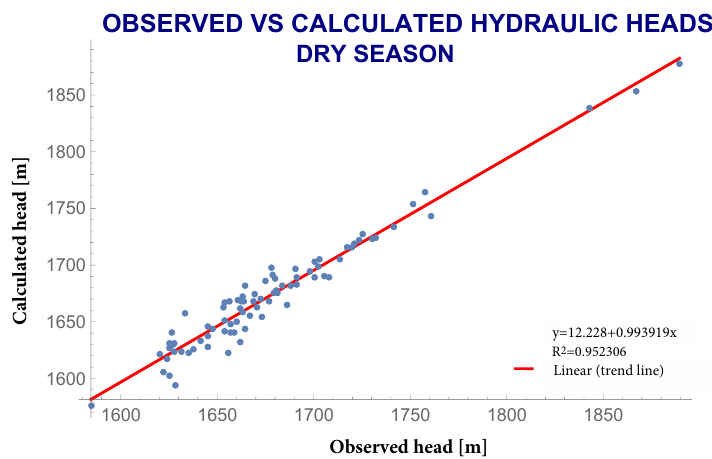
Figura 2.13: Correlaci´on de los niveles piezom´etricos observados y calculados en Temporada de Fig. 14. Correlation of observed and calculated piezometric levels in the Dry Season Figure 13. Correlation of observed and calculated piezometric levels in the dry Secas, 2019.